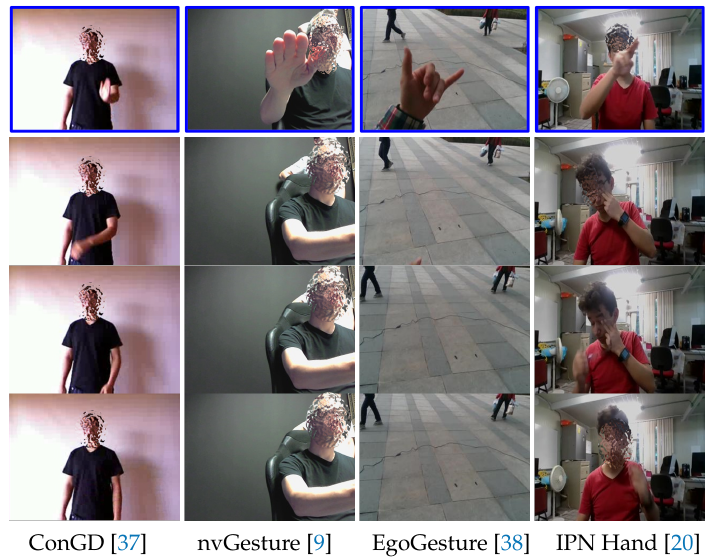
Figure 6. Comparison of gesture vs. non-gesture frames between commonly used hand gesture datasets and the IPN Hand. The first row (blue) shows gesture frames, while the second to fourth rows show non-gesture frames.